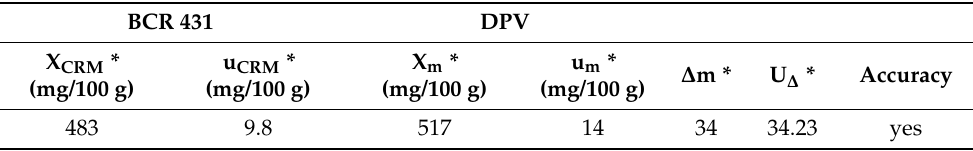
Table 3. Analysis of the accuracy of the differential pulse voltammetric (DPV) method based on the BCR 431 certified reference